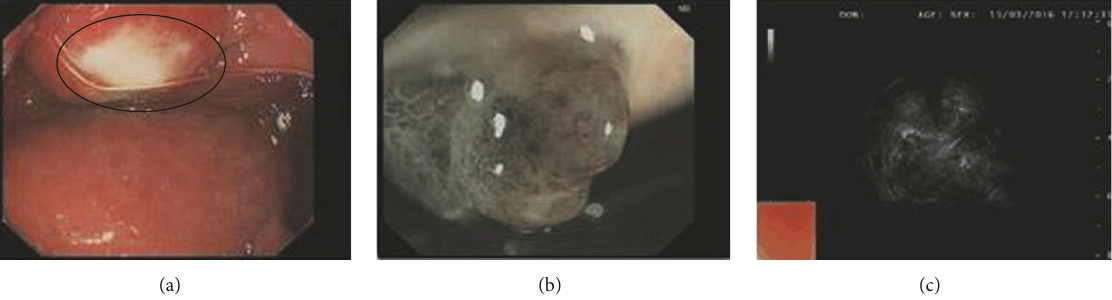
Figure 1: Electronic gastroscope and endoscopic ultrasonography both showed the abnormality of the duodenal mucosa. (a) Electronic gastroscope revealed that there was a mucosal protrusion at the first portion of the duodenum (duodenal bulb) with an ulcerated surface (marked with a circle). (b) NBI and ME showed that the local vascular was disordered, and gland duct disappeared. (c) EUS showed that the hypoechoic mass with uniform echo was at duodenal